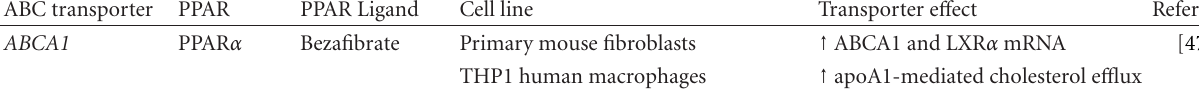
Table 1: In vitro e ff ects of PPAR ligands on ABC